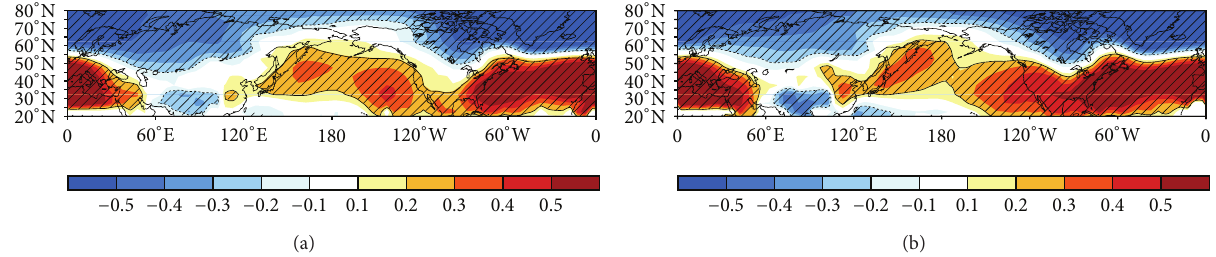
Figure 5: Correlation of NAO with NH SLP for JFM from (a) CMIP1 and (b) like (a) but for CMIP2 significance at 95% (hatched).